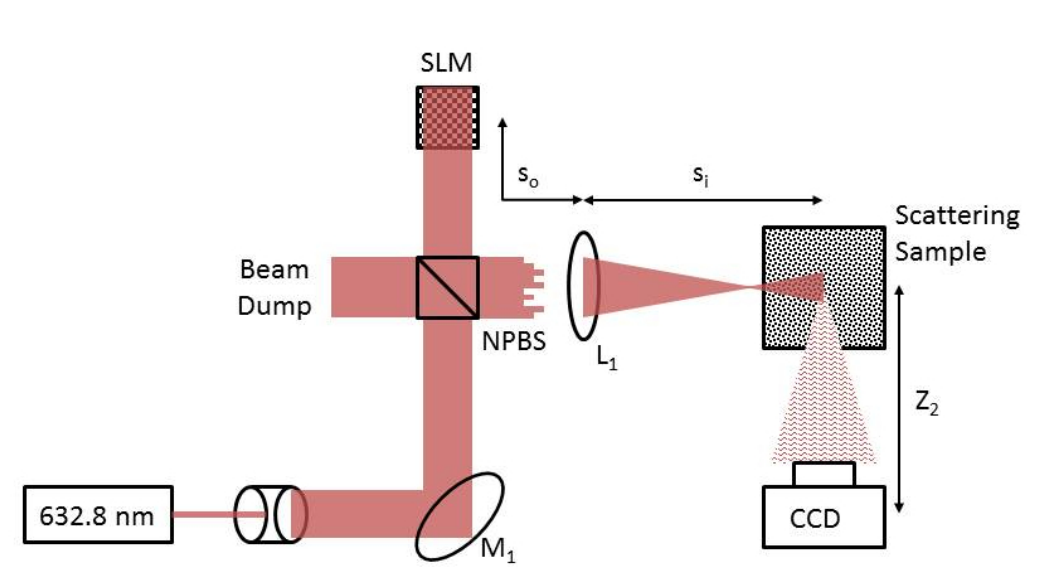
Figure 2. Image plane optical setup for reflective inverse diffusion. A vertically polarized HeNe laser is expanded, collimated, and normally incident on the SLM. The lens ( L 1 ) produces a demagnified image of the phase modulated beam onto the rough-surface reflector and the reflected speckle pattern is recorded by the CCD. The mirror ( M 1 ) and the NPBS are used to allow normal incidence with the s i 1 ≈ SLM. The demagnification of the system is s o